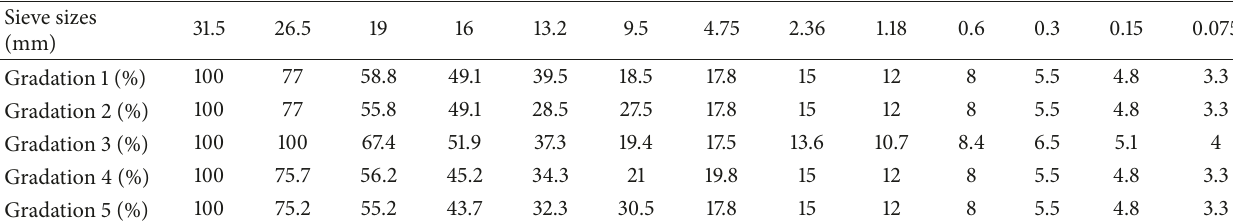
Table 5: Initially designed